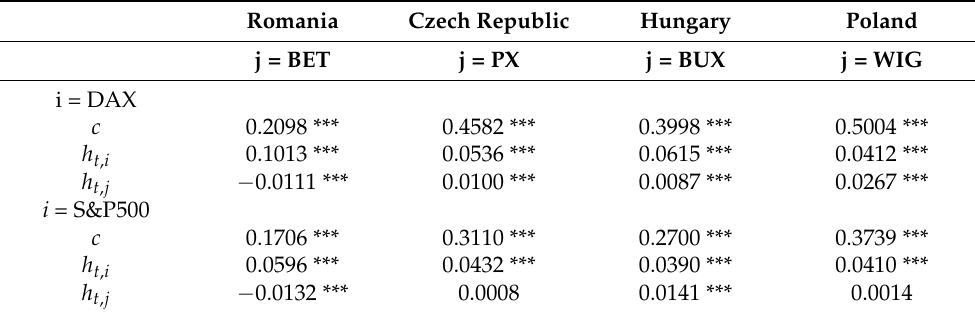
Table A5. The Estimation Results of the Rolling Stepwise Regression Methodology in Analyzing the Relationship between the Conditional Correlation Coefficients and the Conditional Volatilities.